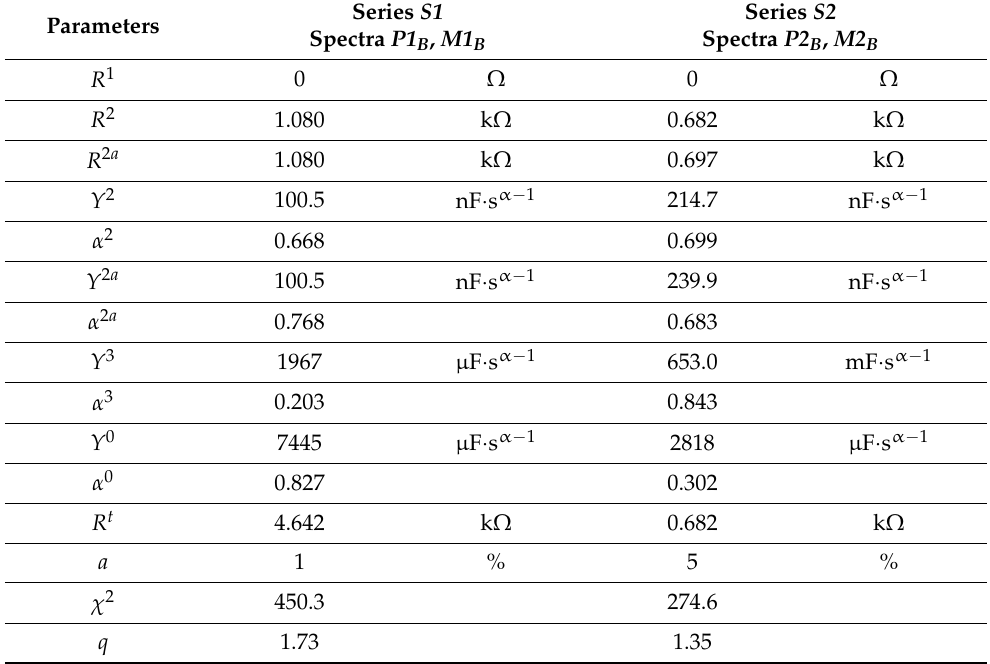
Table A1. Electrochemical parameters of initial spectra, introduced into Formulas for the 3D model to simulate the effect of a varying width B E of the counter electrode and statistical evaluation of matching the model spectrum to the empirical one.